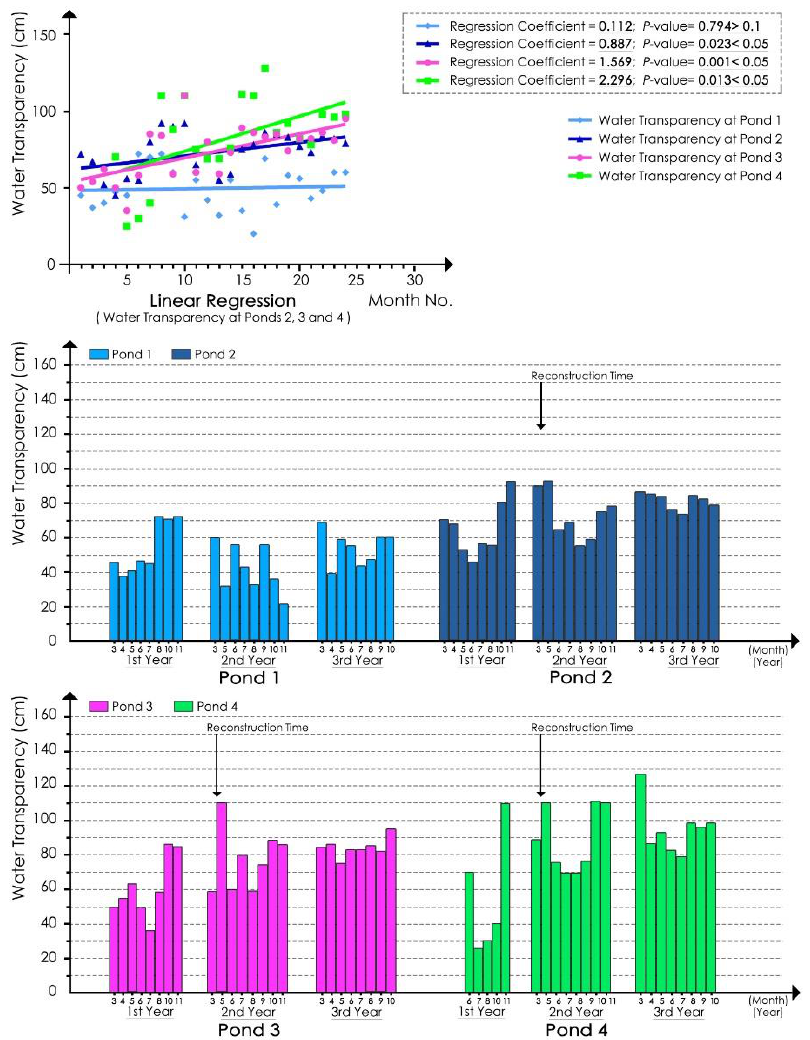
Figure 3. Water transparencies for ponds 1, 2, 3, and 4.